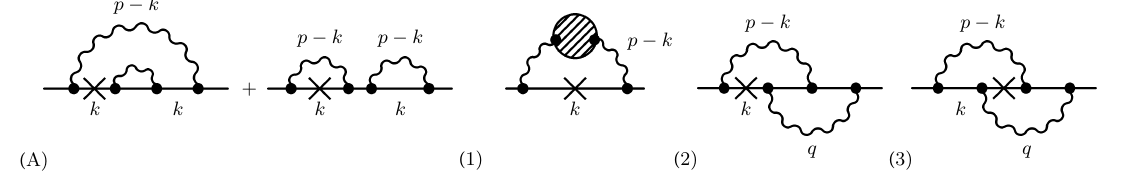
Figure 2. NLO diagrams for dynamically generated mass Σ ( p ) . The symbol (A) shows the contribution of the LO fermion wave function and symbols (1), (2) and (3) correspond to the different topologies of the NLO corrections themselves. The shaded blob contains the sum of the diagrams shown in Figure 3.